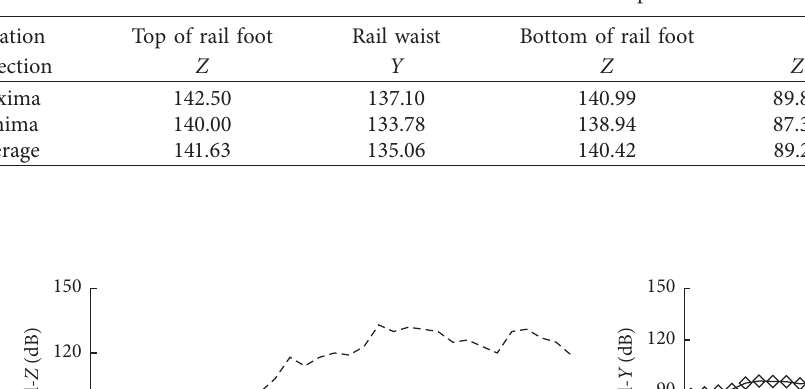
Figure 15: Acceleration contour of surrounding soil layers: (a) Z direction; (b) Y direction. Table 7: Vibration levels at measurement points in the tunnel (unit: dB).